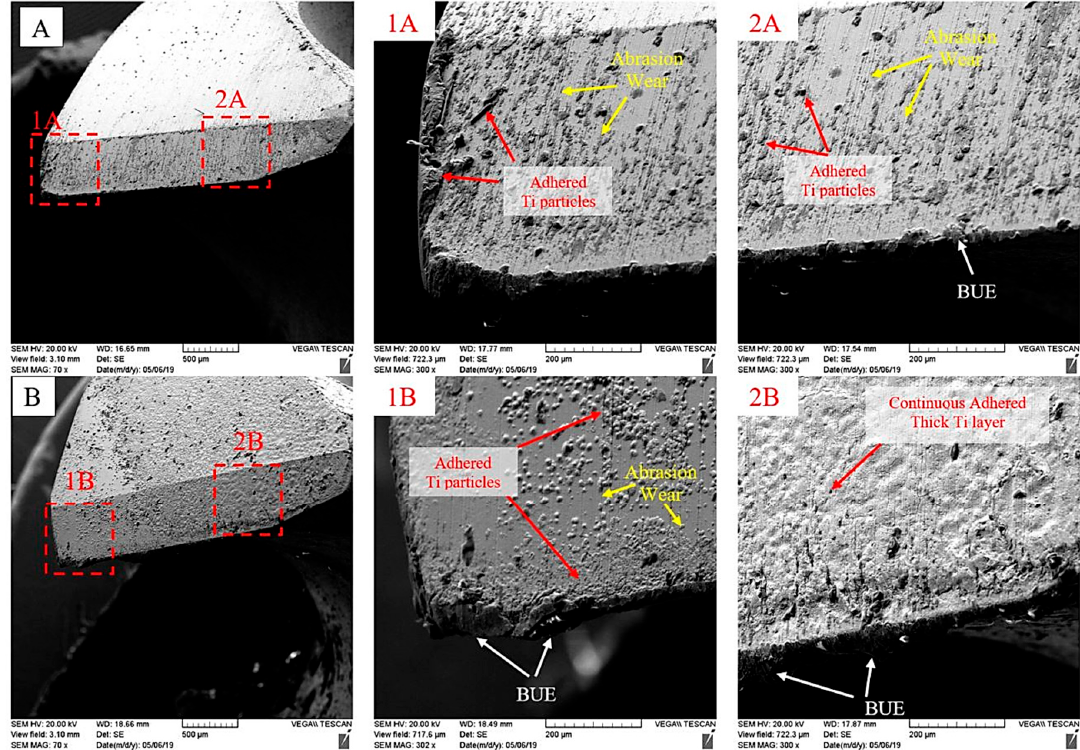
Figure 13. The SEM flank surface examination for ( A ) VAD at A m = 0.25 mm and ( B ) conventional drilling at N = 37.68 m/min and f = 0.075 mm/rev.